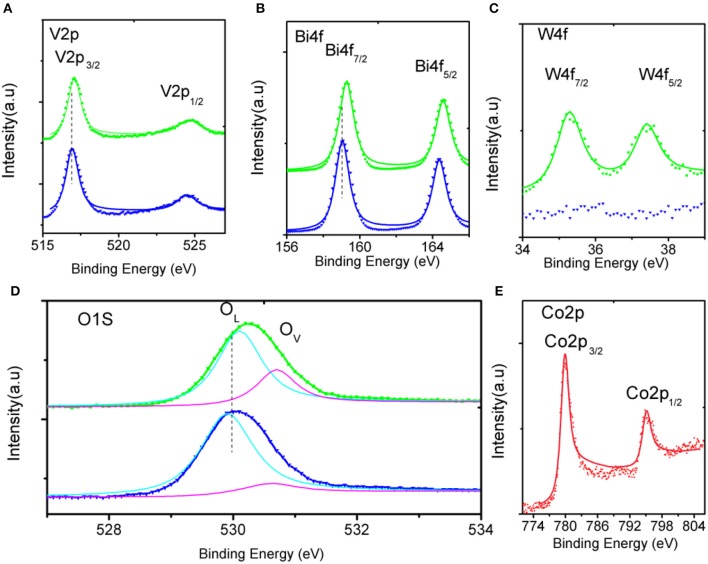
High-resolution XPS spectra of (A–D) in the pristine (blue), doped (green) BiVO4 nanotubes, and (E) in Co-B.